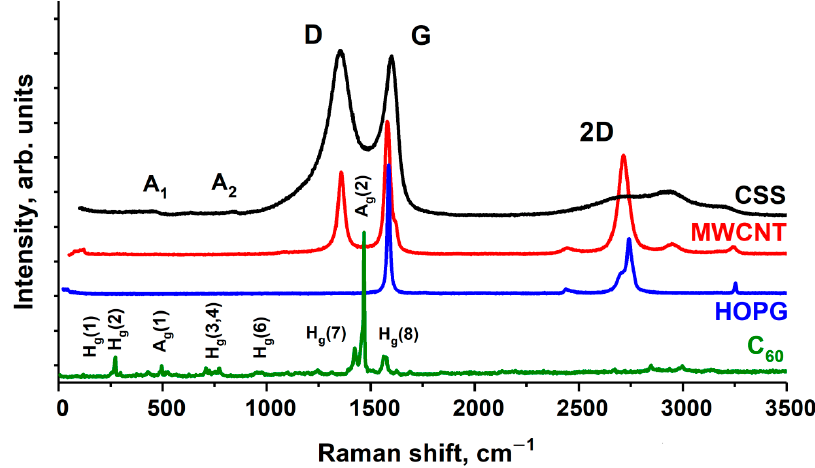
Figure 1. The Raman spectra of the fullerite C 60, HOPG, MWCNTs and CSS. The diffractograms of MWCNTs, fullerite C 60 and CSS are shown on Figure 2. Full ‐ erite XRD patterns consist of a sequence of narrow peaks, whose positions correspond to a face ‐ centered molecular crystal with a lattice constant of 1.417 nm and a distance be ‐ tween C 60 molecules of 1.002 nm [30,32,33].